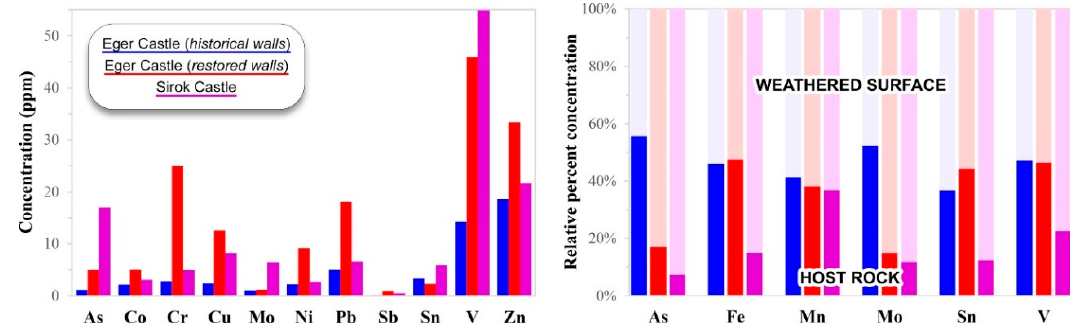
Figure 7. Average concentration of heavy metals determined by ICP-MS on the weathered surface of the studied tuffs, and comparison with the relative abundance of selected elements in the host